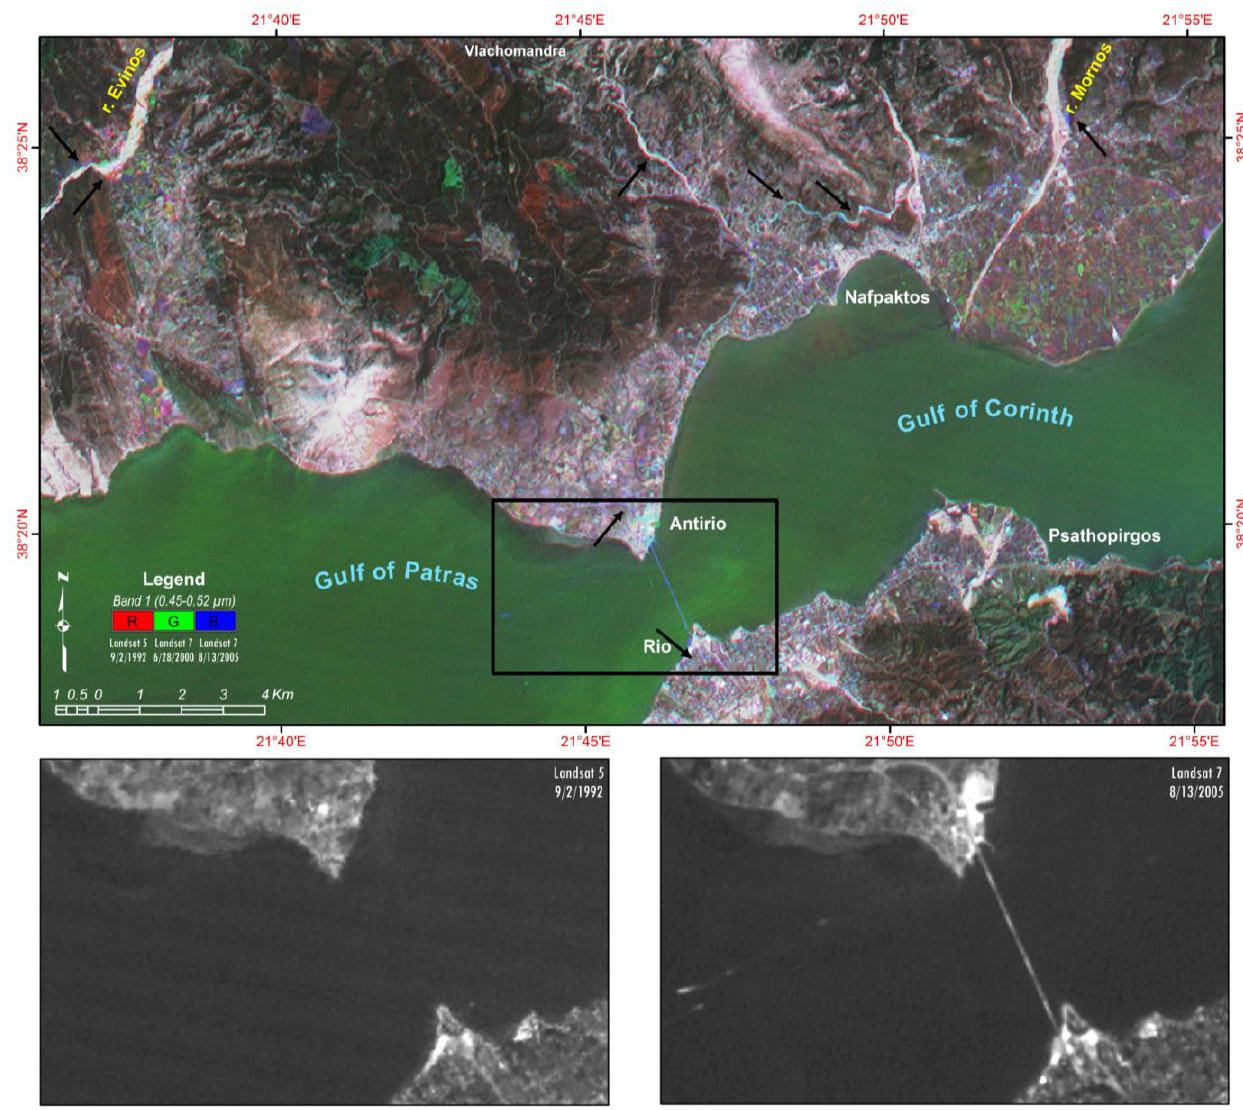
Figure 2. Multi-temporal pseudo-color image produced from layer stacking of Landsat satellite data (Band 1, 0.45 to 0.52 μm) with three different acquisition dates. The diachronic changes in onshore and offshore areas, largely due to infrastructure development after 2000, are clearly shown as blue linear features. The black arrows point to alterations of the surface described in the text. Below, two single band-1 enlargements of the black rectangle area show the changes caused by the bridge construction during the period from 1992 (left) to 2005